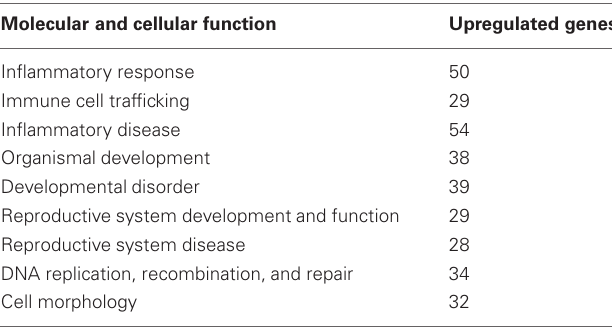
Table 1 | Functional categorization of genes that were upregulated by neonatal LPS exposure.